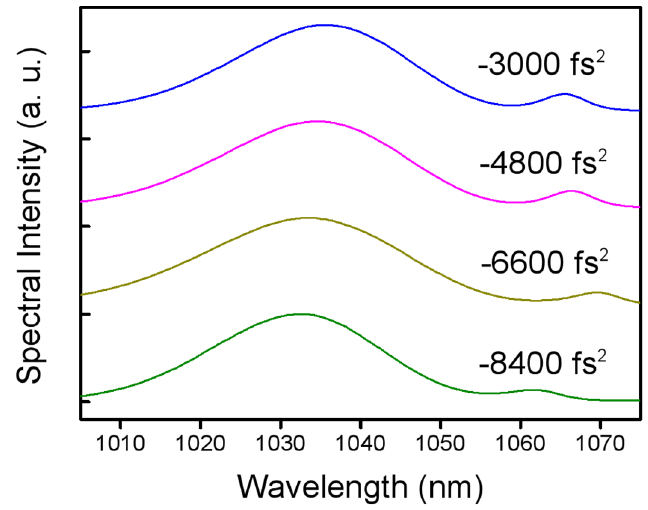
Figure 3. The evolution of the output optical spectra with − 3000, − 4800, − 6600 and − 8400 fs 2 for the net cavity dispersion. The corresponding grating separations are 1.0, 1.2, 1,4, and 1.6 mm, respectively. The spectra were recorded with 1.5 W for the injected pump power. The measured spectra are presented in linear scales.